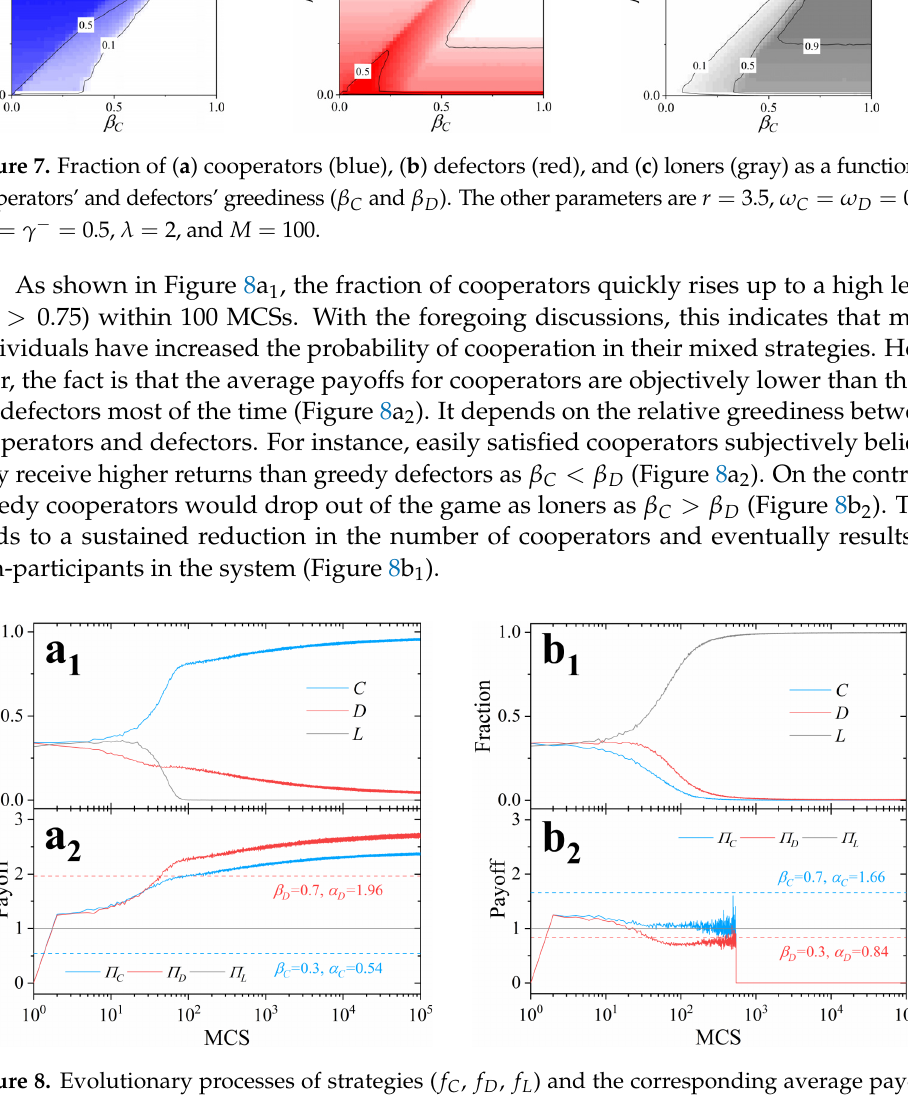
, 𝑓 , 𝑓 ) and the corresponding average payoffs ( 𝛱 (cid:3004) , 𝐿 𝐶 𝐷